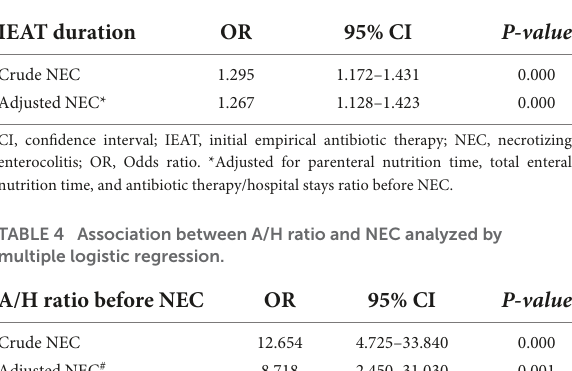
TABLE 3 Association between IEAT and NEC analyzed by multiple logistic regression.